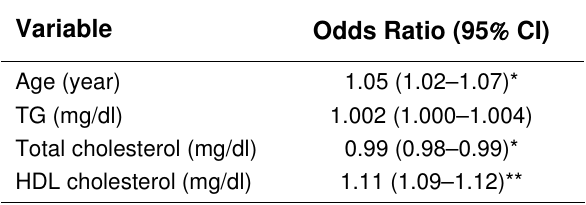
The Relative Risk of Angiographically Defined CAD Associated with Individual Coronary Risk